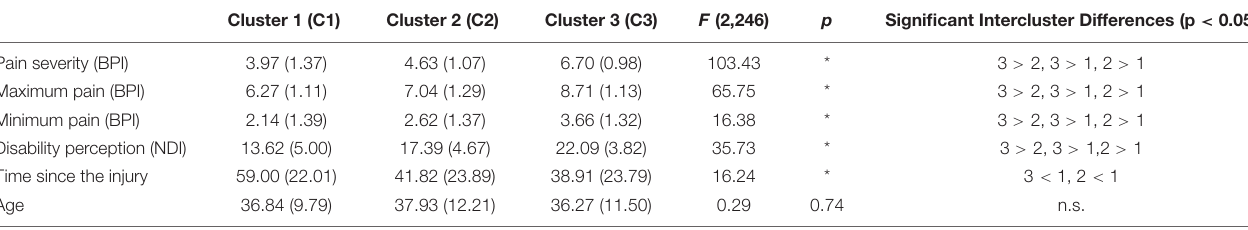
TABLE 3 | Means, SD, and ANOVAs of the profiling